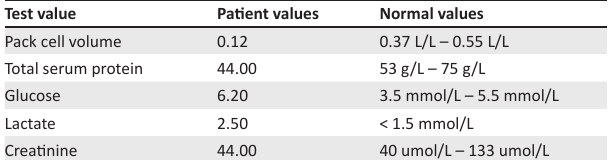
TABLE 1: Initial findings.